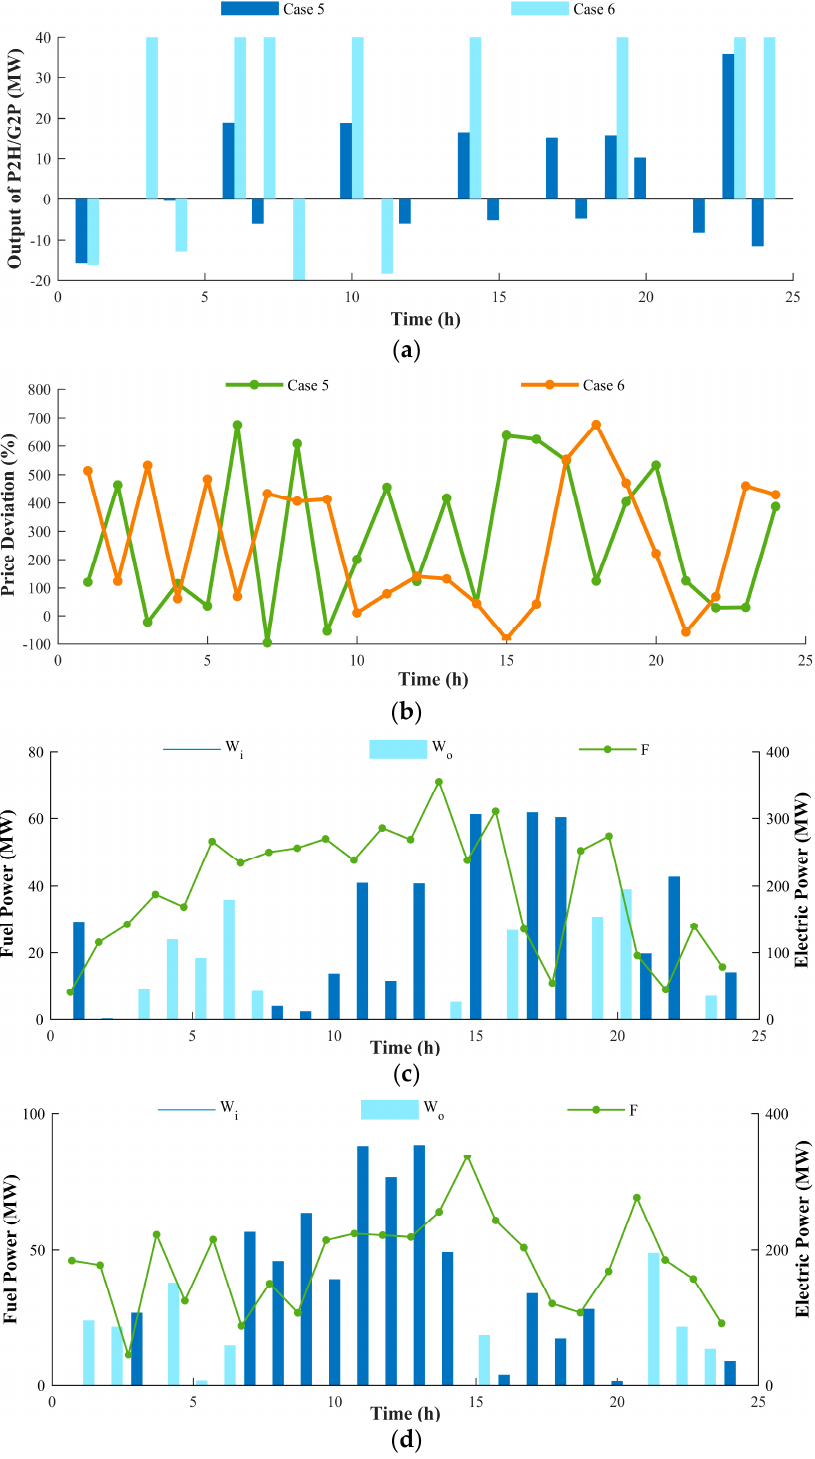
Figure 12. Dispatch result in Case 5 and Case 6. ( a ) Outputs of conventional generators and the wind turbine. ( b ) Price deviation for EV charging. ( c ) Input and output of CCHP plant in Case 5. ( d ) Input and output of CCHP plant in Case